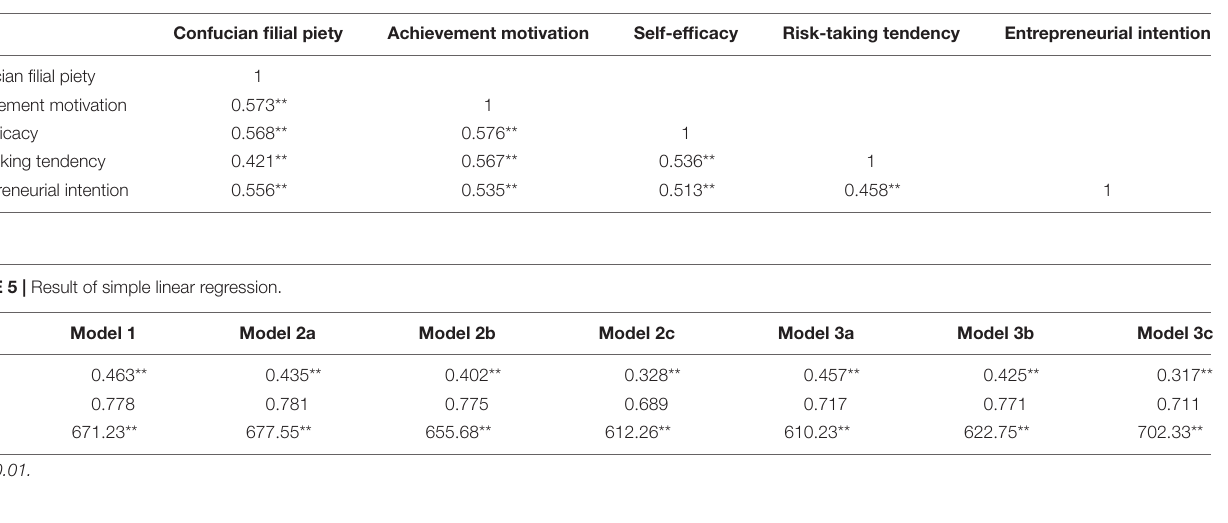
TABLE 4 | Correlation between the variables.